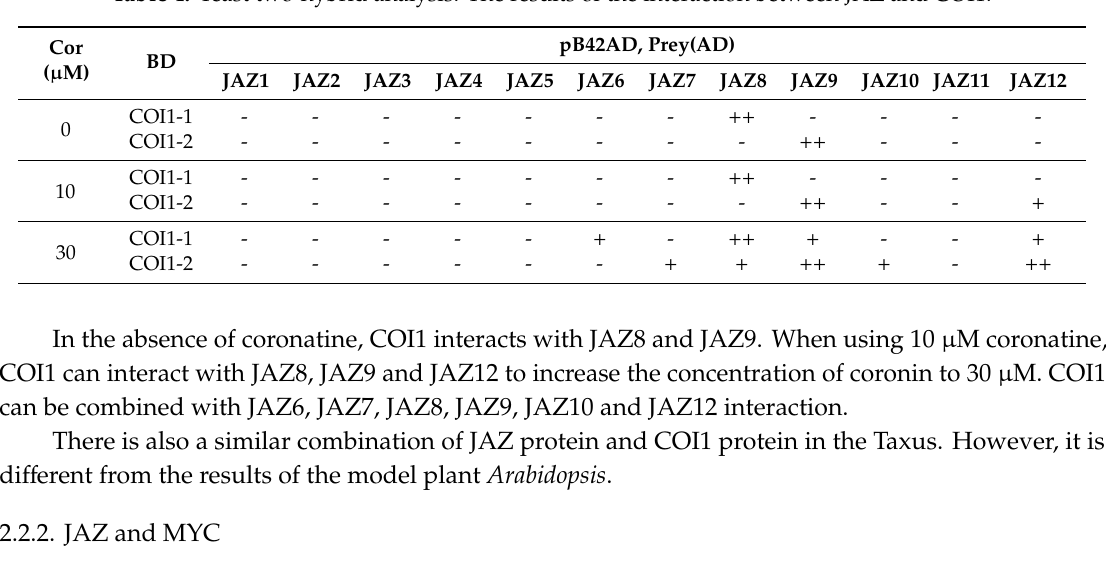
Table 4. Yeast two-hybrid analysis. The results of the interaction between JAZ and COI1.